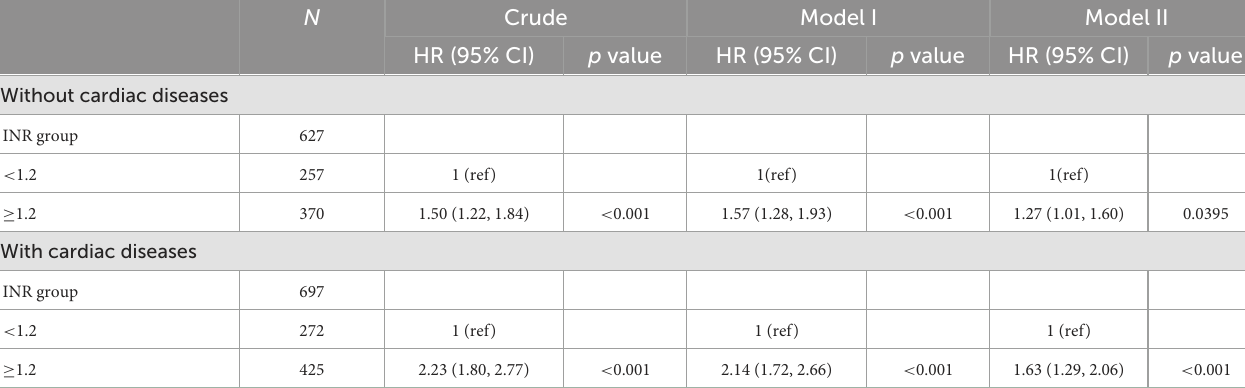
TABLE 4 Sensitivity analysis of the association between INR and 1-year all-cause mortality in post-CA patients with or without cardiac